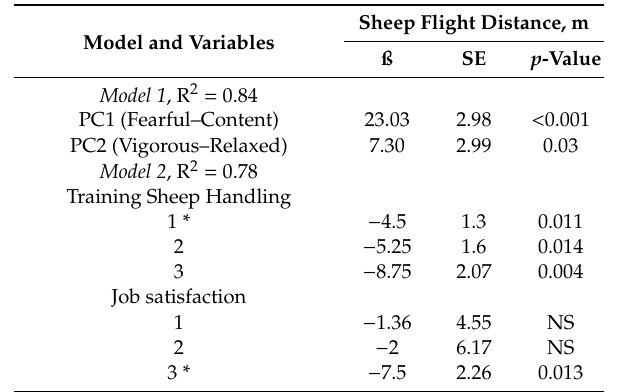
Table 6. Multivariable linear regression models evaluating the association of the average flock flight distance (outcome) with the behavioral principal components (model 1), that characterized valence (PC1) and energy (PC2) of the flock of sheep and the level of job satisfaction perceived by producers and the number of training courses taken by the producer in the last 2 years (model 2).